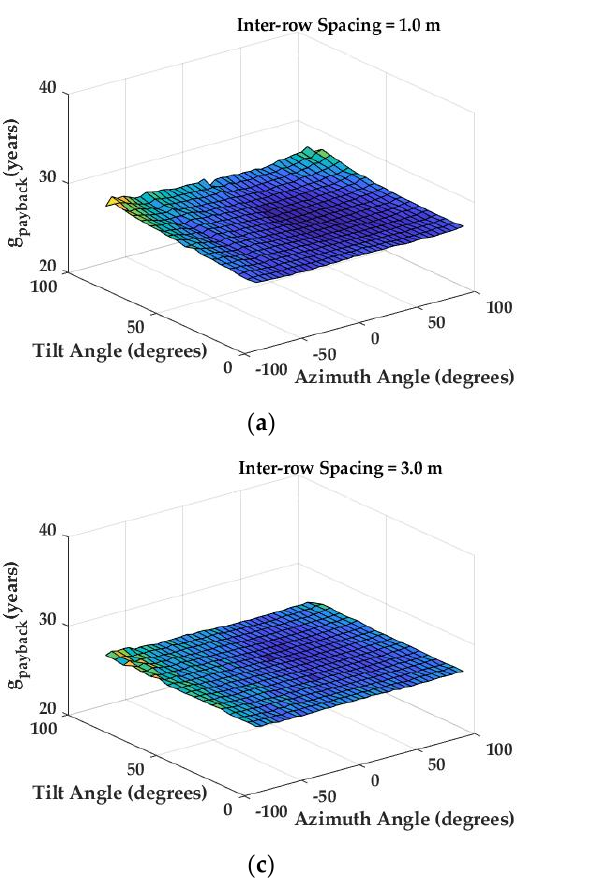
Figure 21. Objective function variation with tilt and azimuth angles for the CAM building for ( a ) L ir of 1.0 m, ( b ) L ir of 2.0 m, ( c ) L ir of 3.0 m, and ( d ) L ir of 4.0 m.